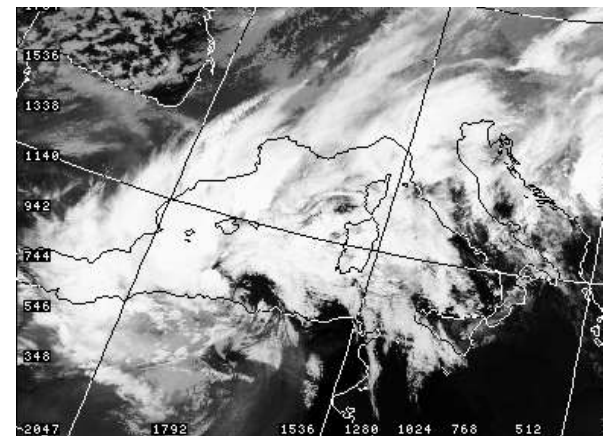
Fig. 7. IR NOAA satellite picture (Channel 4) at 14:00UTC,